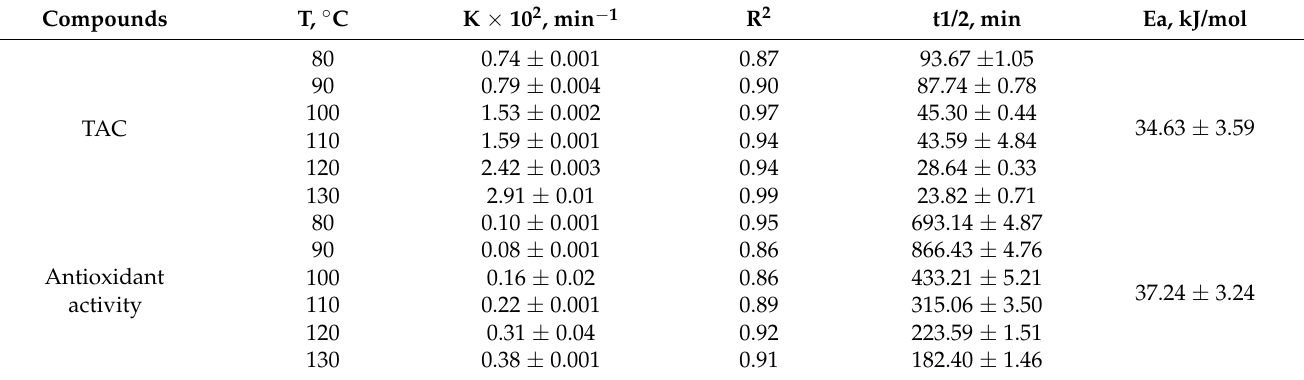
Table 4. Estimated kinetic parameters of bioactives in eggplant peel